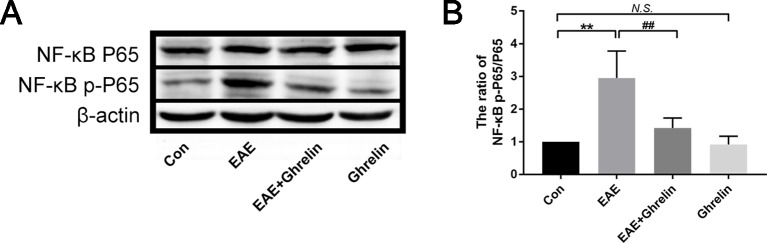
Treatment of ghrelin inhibited NF-κB activation in EAE rats. (A) Representative western blot images of changes in the expression level of NF-κBP65 and NF-κB p-P65. (B) The ratio of NF-κB p-P65/NF-κBP65. Data were shown as mean ± SD (n = 5).**P 0.01 versus the control group, ##
P 0.01 versus the EAE group. NS, not significant. Con, control.